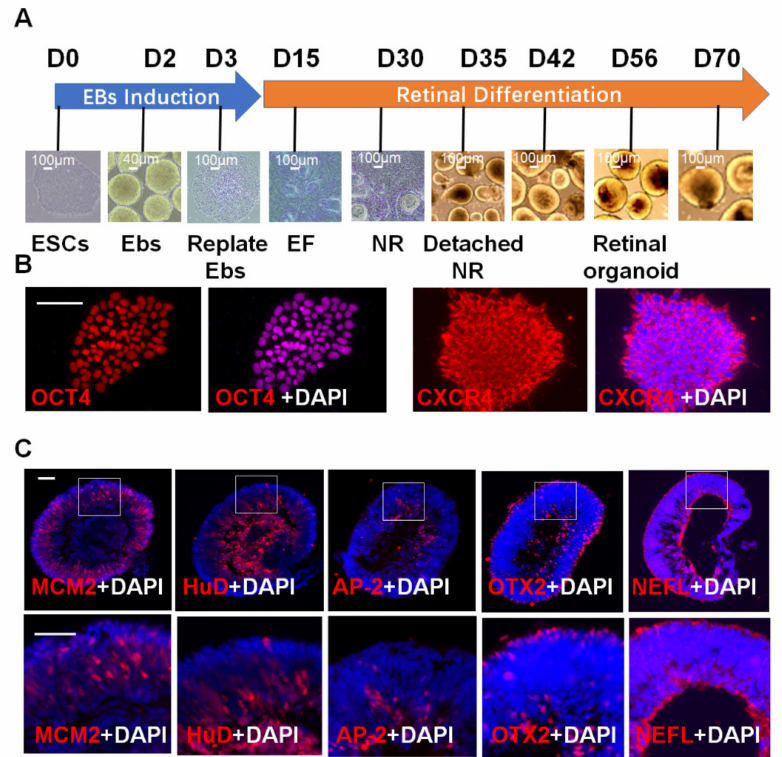
Figure 1. 3D retinal organoids generated from H9 hESCs contain major retinal cell types arranged in proper layers. ( A ) A scheme of retinal organoids generated by hESCs H9. ( B ) hESCs H9 were stained for OCT4 and CXCR4. ( C ) After 10 weeks of differentiation, retinal organoids contained major cell types of retinal cells, including progenitor cells (MCM2-positive), ganglion cells (HuD-positive), amacrine cells (AP-2 α -positive), and photoreceptor cells (OTX2-positive), and showed a normal axon pathway (NEFL staining). Scale bars: 100 µ m ( B , C